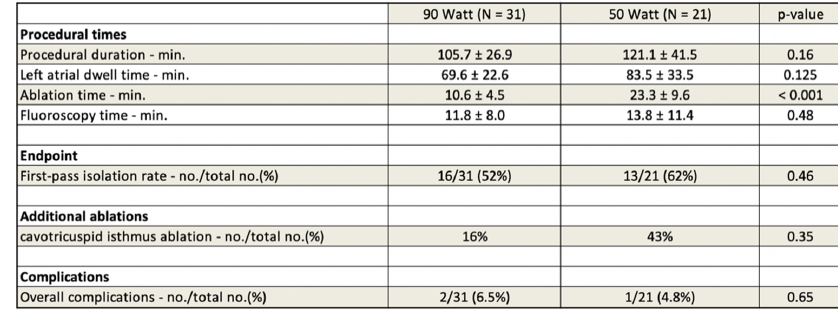
Figure 2. Procedural data.